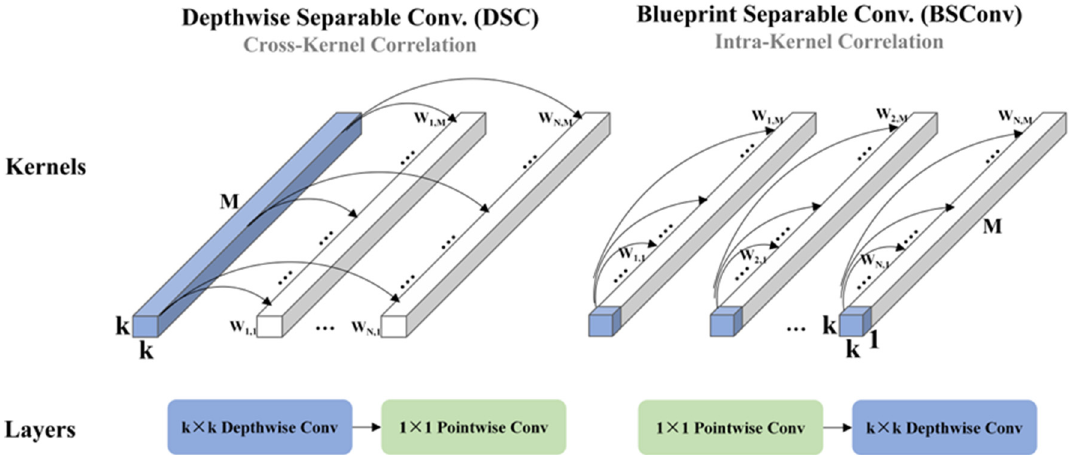
Figure 5. Interpretation for DSC and BSConv.